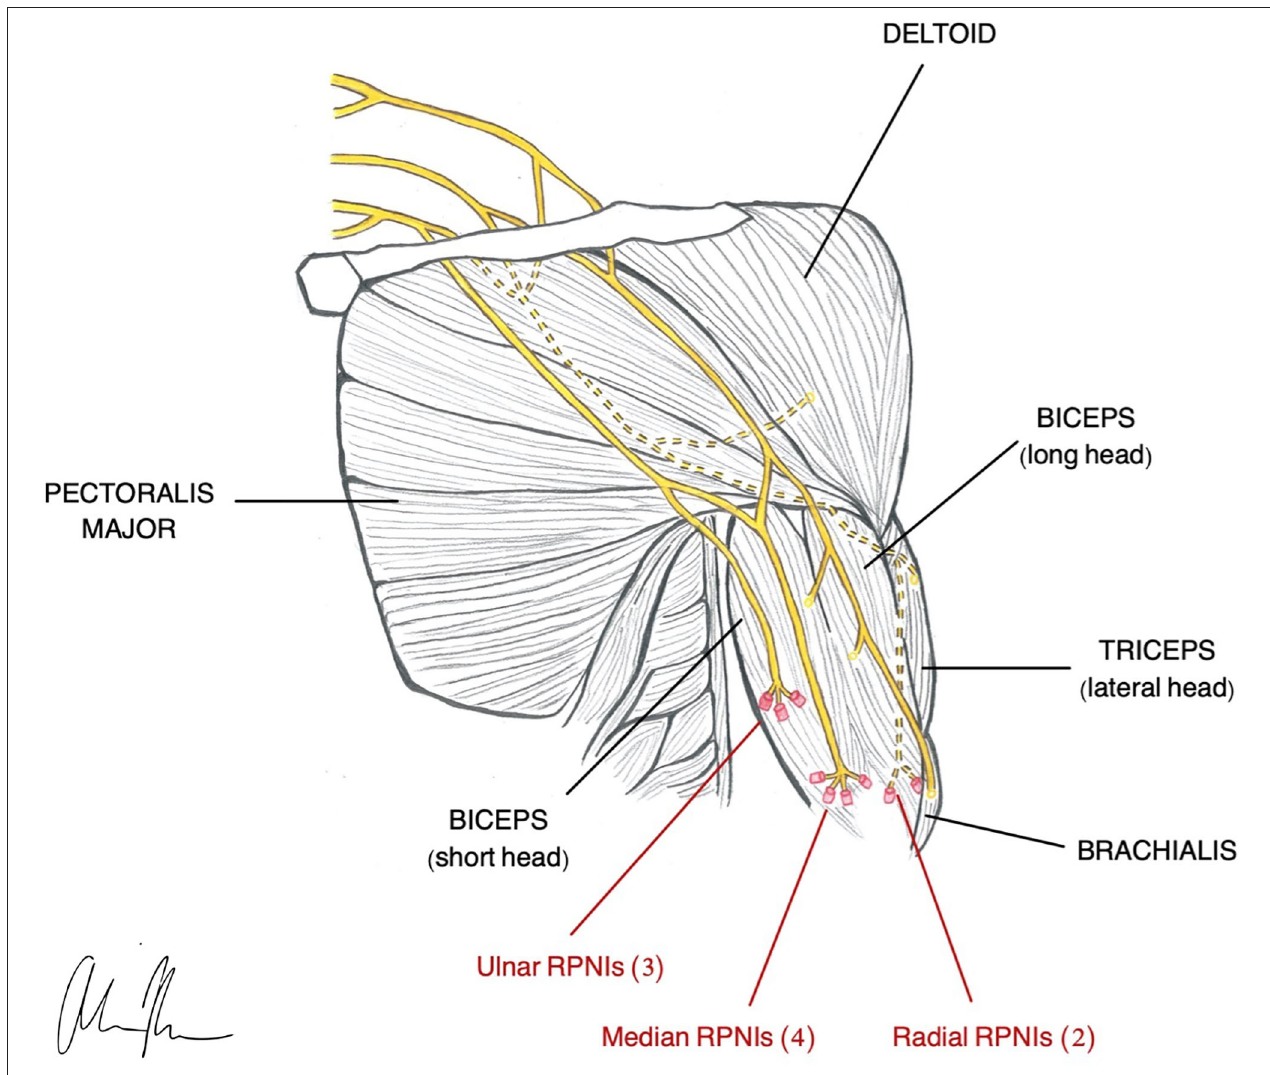
FIGURE 2 | Illustration of RPNI construction in a transhumeral amputee (Vu et al.,